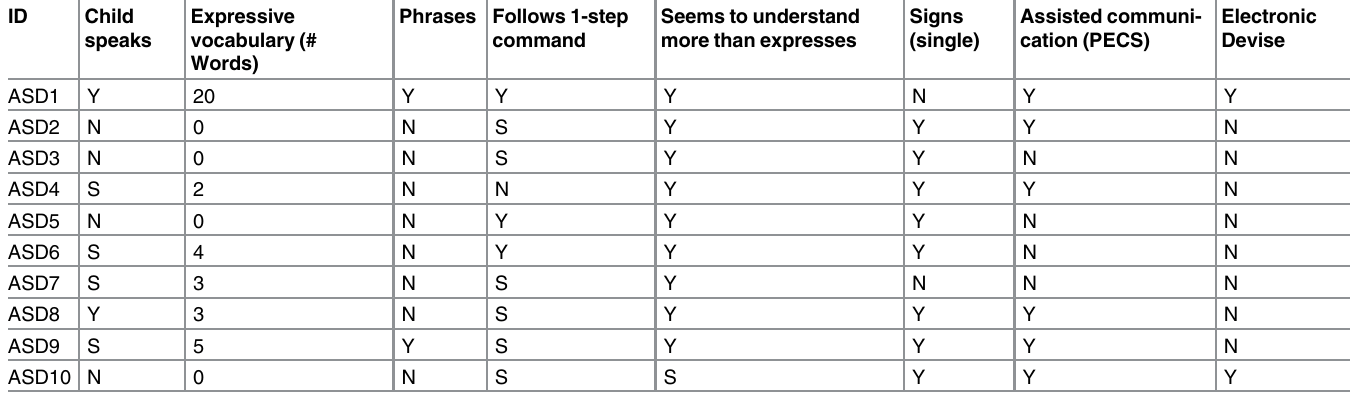
Table 1. Summary of communication